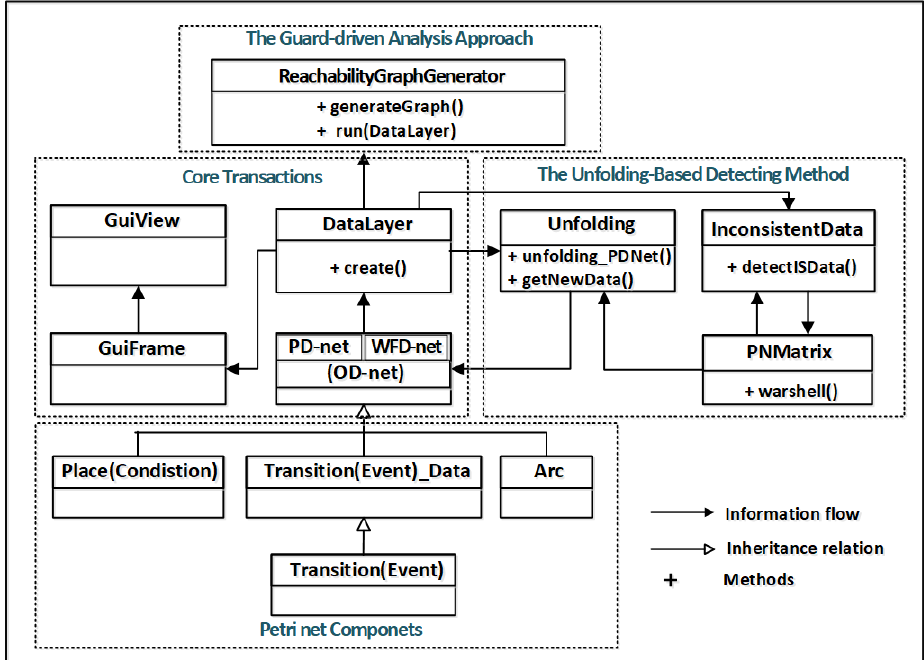
Figure 8. Main class